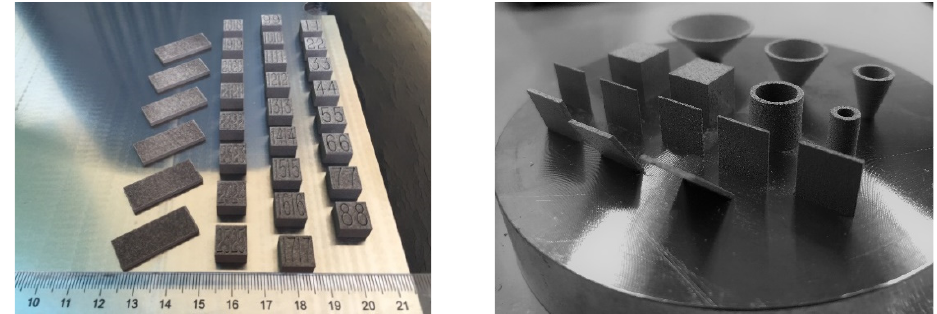
Figure 4. The SLM fabricated parts built up by orthogonal process parameter.